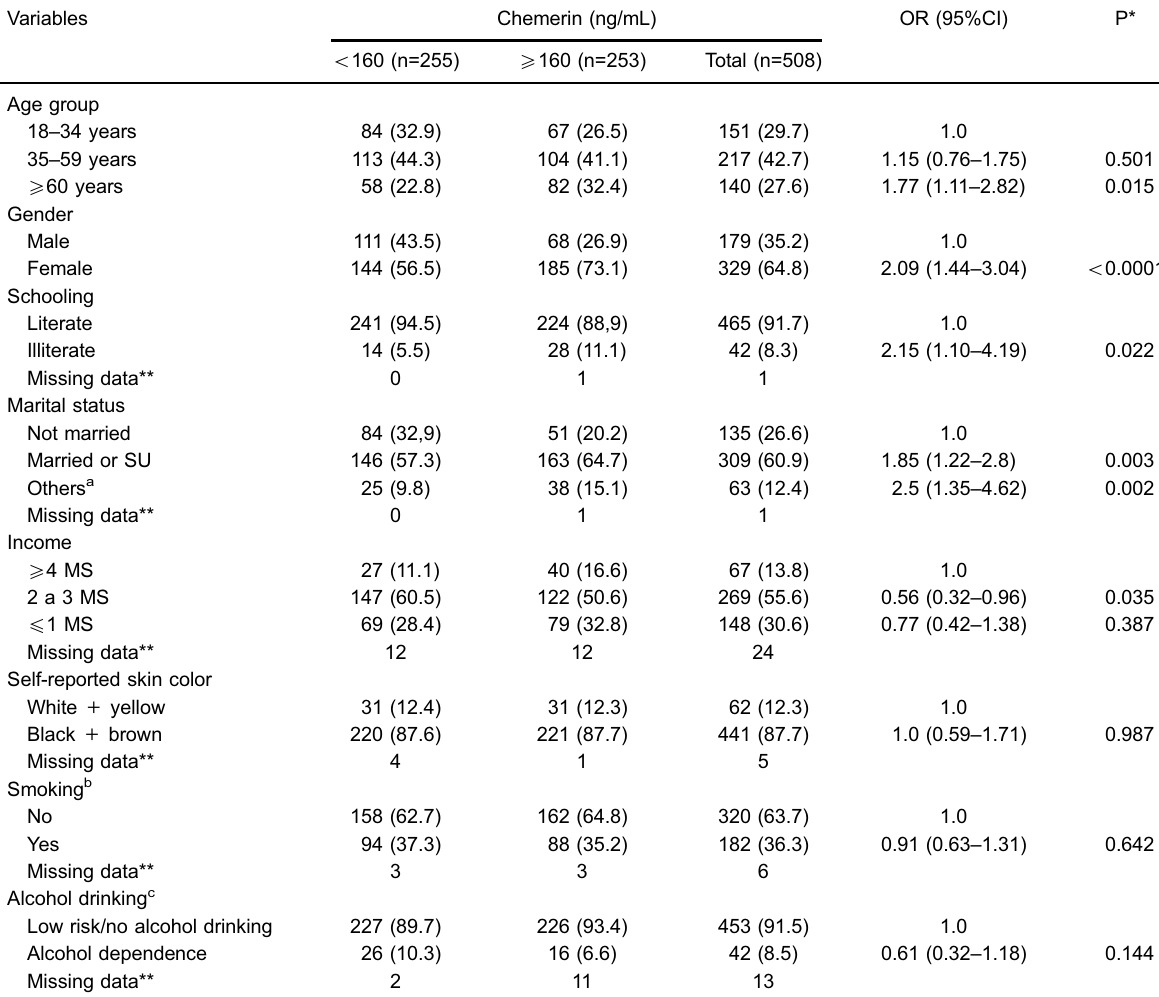
Table 2. Socio-demographic and behavioral characteristics of the study population by quartiles of